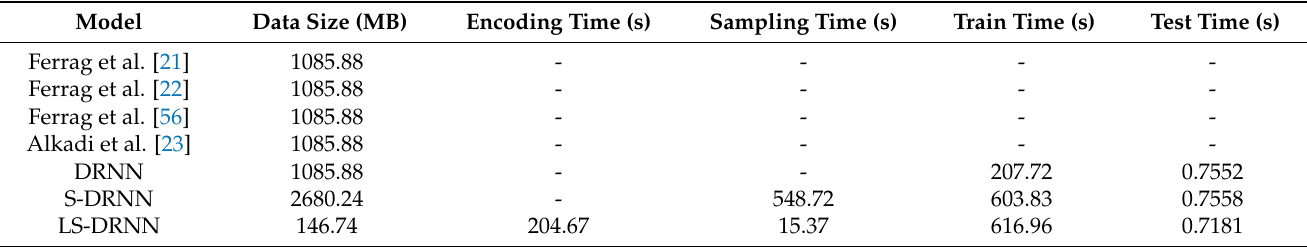
Table 3. Data size and computation